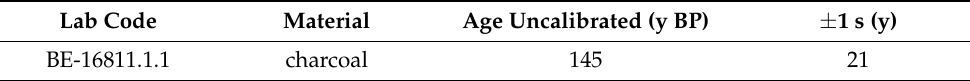
Table 1. Radiocarbon date for structure